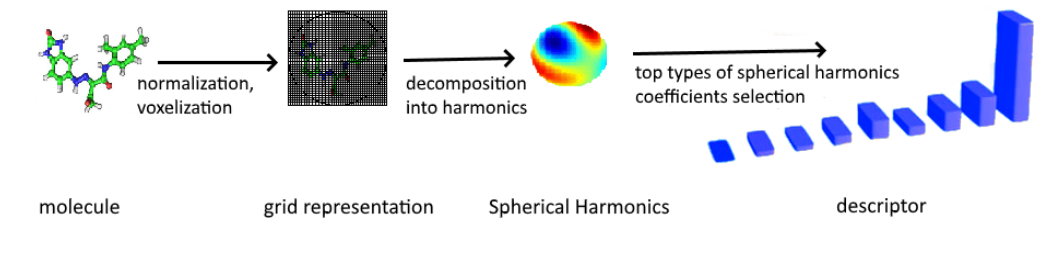
Figure 7. Steps in computing Spherical Harmonics-based